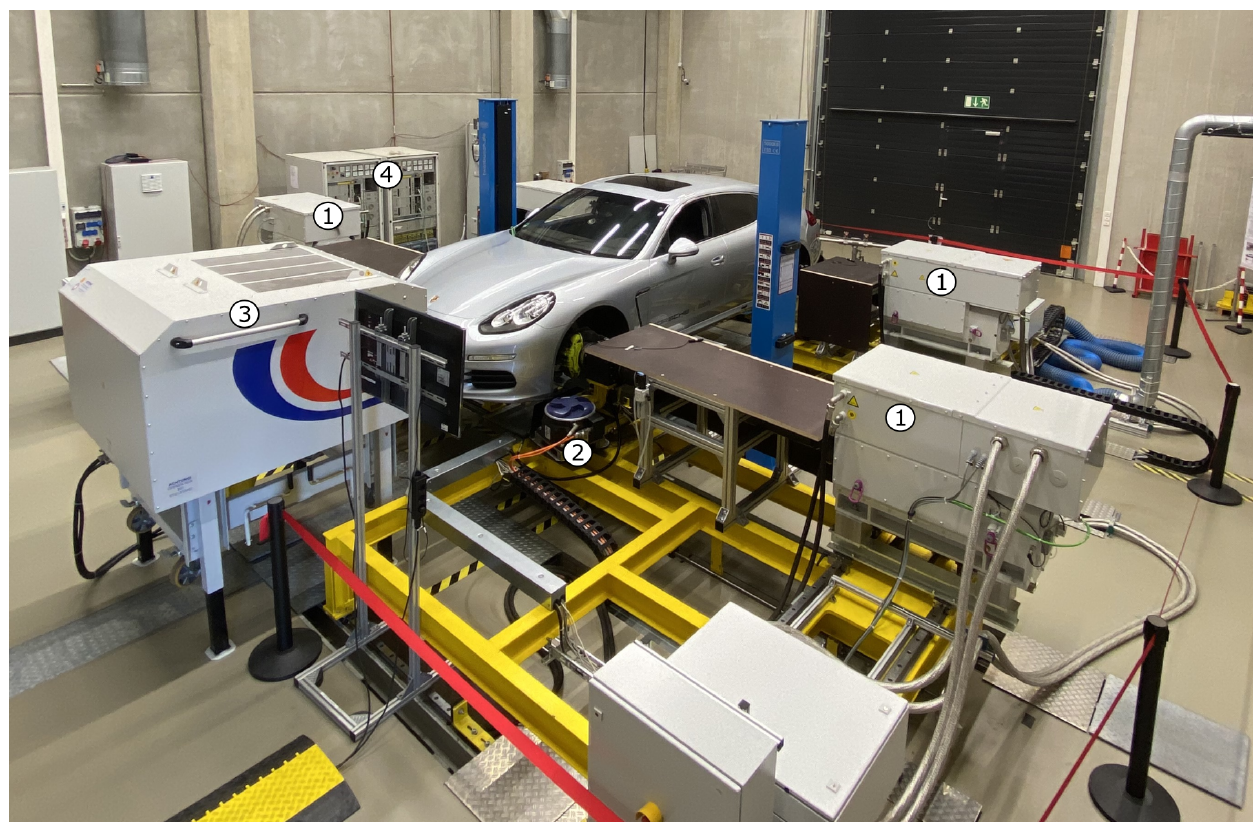
Figure 3. Vehicle-in-the-Loop test